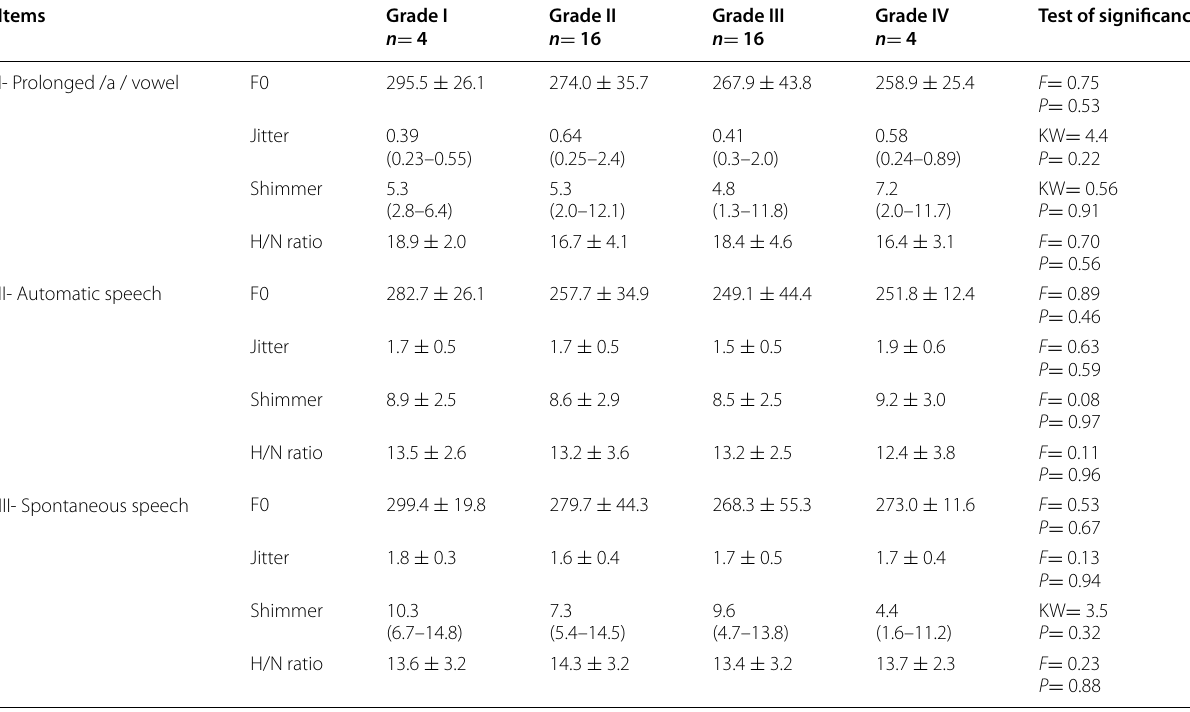
Table 8 Association between acoustic parameters and Bloodstien (BLD) grade in the stuttering